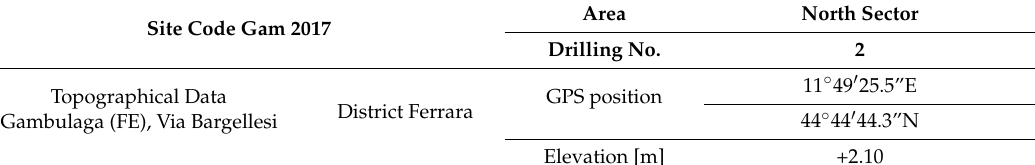
Table A2. Drilling No. 2.